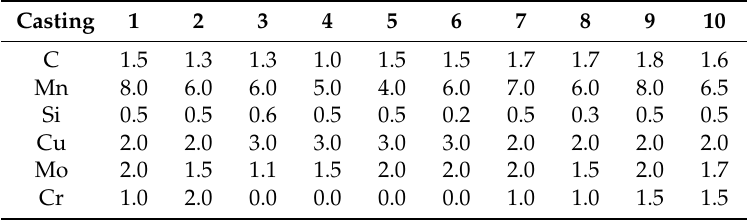
Table 1. Chemical composition of the proposed castings